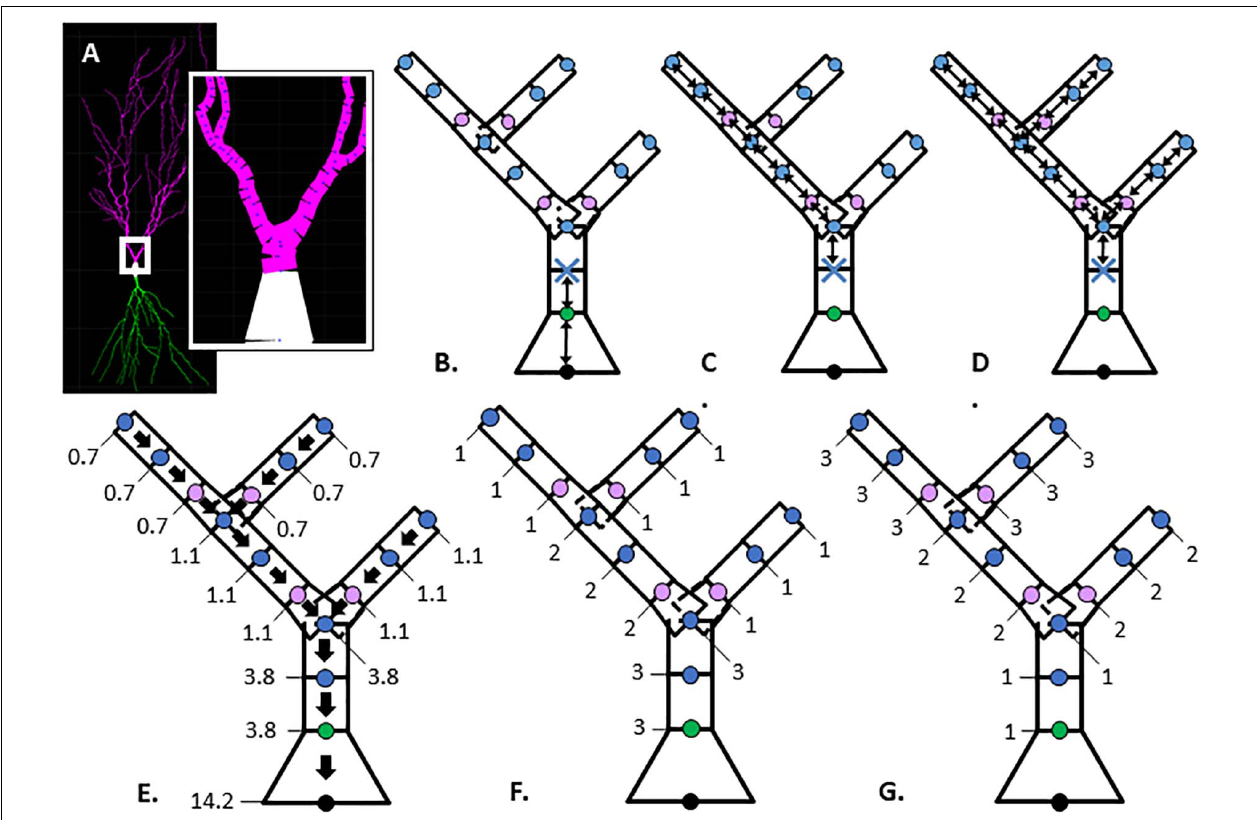
FIGURE 1 | Illustration of morphological features. (A) Hippocampal CA1 pyramidal neuron visualized with Cvapp from NeuroMorpho.org (NMO_00817, left panel); start of apical branch (right panel) with compartments (magenta) between individual nodes (blue dots). (B–G) Simplified dendritic morphology of apical branch to demonstrate morphology feature values for each node. Nodes (points) classified as soma (black), initial (green), continuing (blue), and branch children (lavender). Further feature description in Table 2 . (B–D) Arrows indicate path distance between nodes used to calculate feature values originating at the first continuing node, marked with blue X. (B) Path from soma. (C) Longest Path to Terminal End. (D) Total Dendritic Length Rooted at Node. (E) Parent Diameter; arrows point to parent node and values provide the node diameter ( µ m). (F, G) Feature values indicate node positional relationship in branch arrangement within morphology. (F) Terminal Degree. (G) Initial Branch